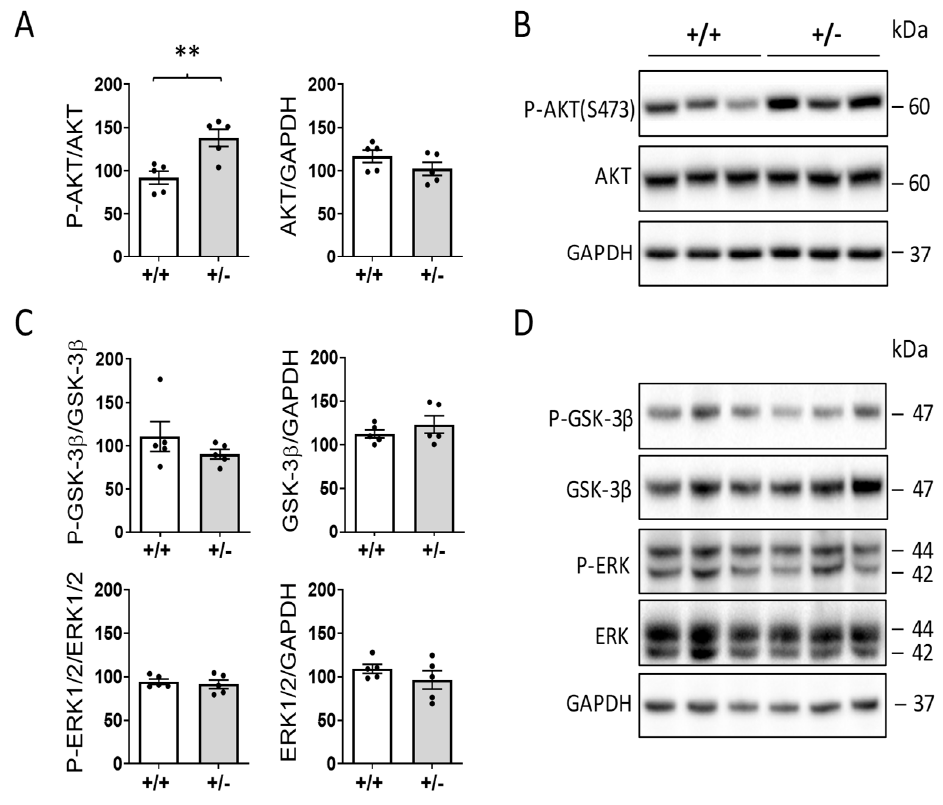
Figure 4. AKT, GSK-3 β , and ERK pathways in the hearts of Cdkl5 +/ − mice. ( A ) Western blot analysis of phosphorylated AKT (P-AKT, Ser473) levels normalized to total AKT content (left histogram) and total AKT levels normalized to GAPDH levels (right histogram) in ventricular extracts from Cdkl5 +/+ (n = 5) and Cdkl5 +/ − (n = 5) mice. ( B ) Examples of immunoblots for P-AKT, AKT, and